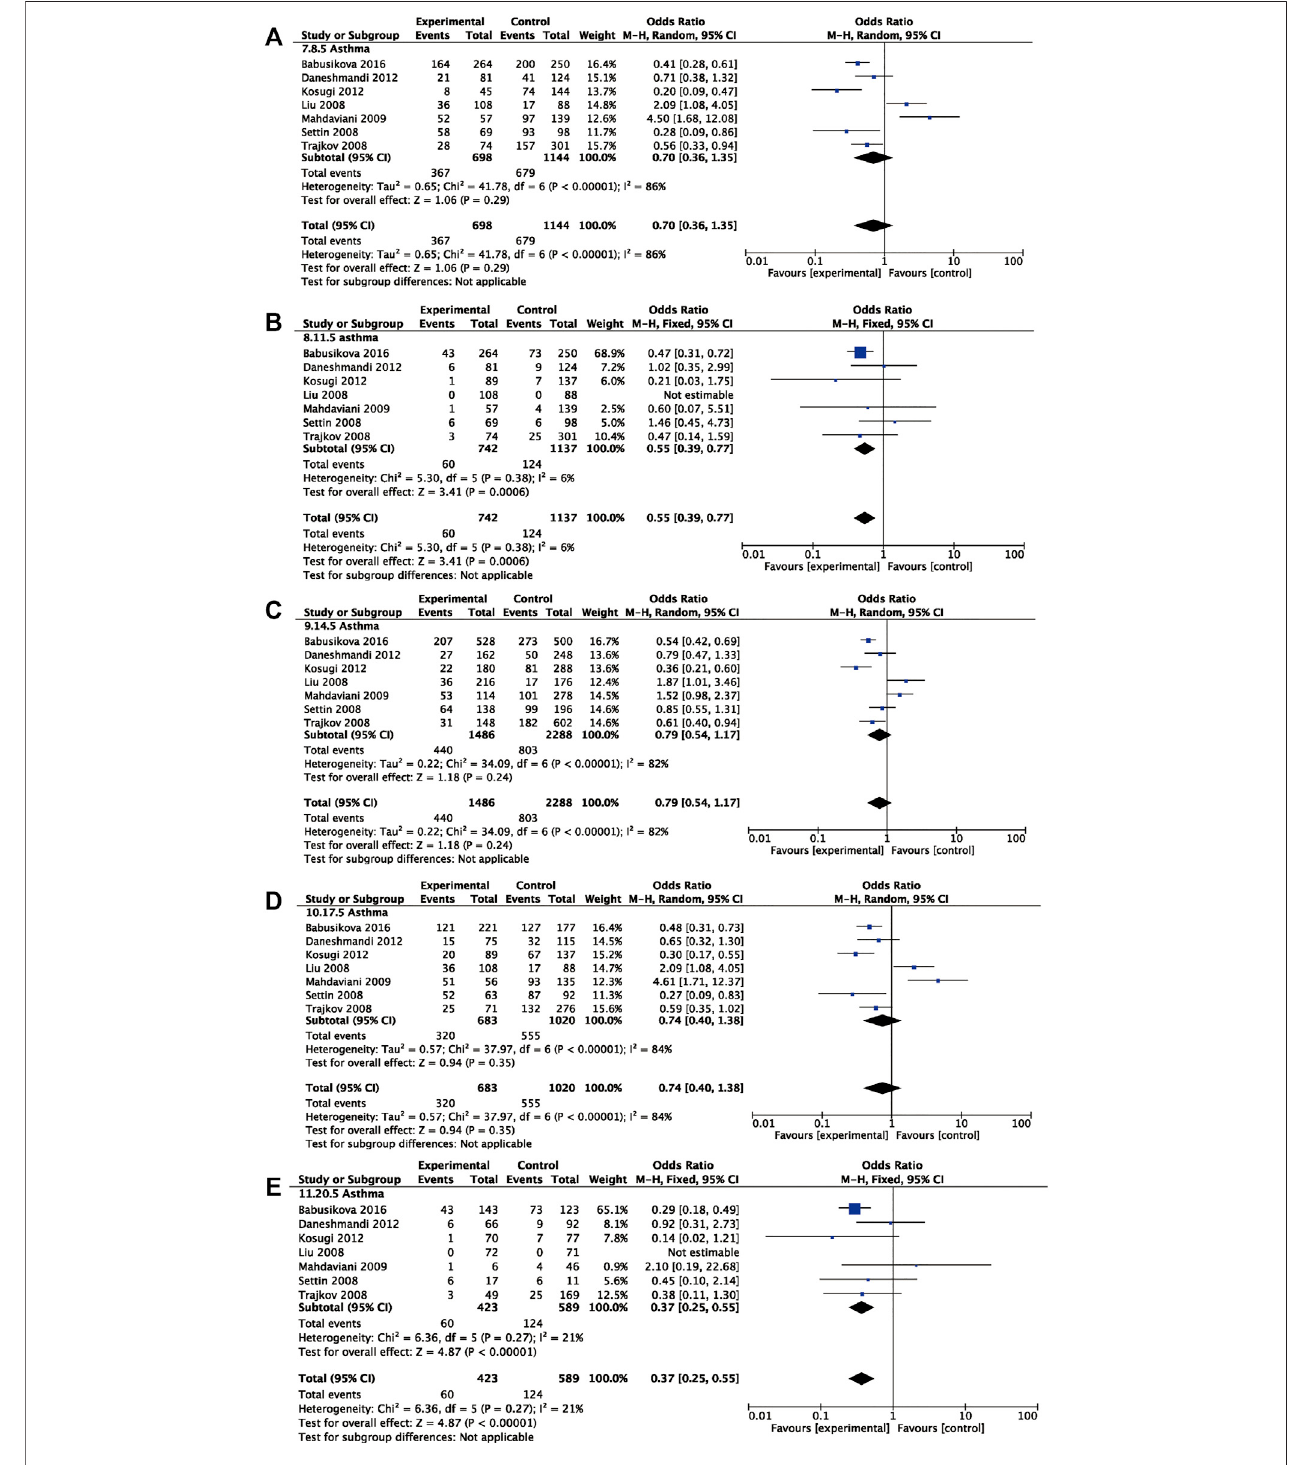
FIGURE 4 | Pooled OR and 95% CI of individual studies and pooled data for the association between IL-6 rs1800795 polymorphism and asthma risk for (A) dominant comparison, (B) recessive comparison, (C) allele comparison, (D) heterozygote comparison, and (E) homozygote comparison.